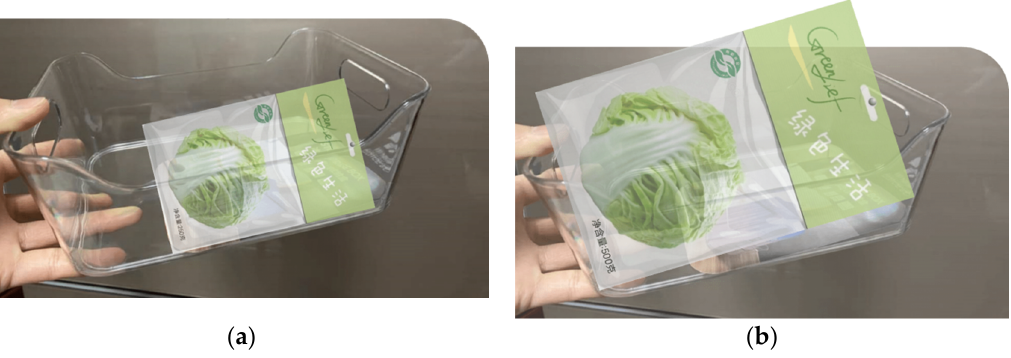
Figure A1. ( a ) Small package size. The Chinese meaning of the above figure is “Small package size ‘firewood yard’ Wuchang organic rice”. ( b ) Large package size. The Chinese meaning of the above figure is “Large package size ‘firewood yard’ Wuchang organic rice”.